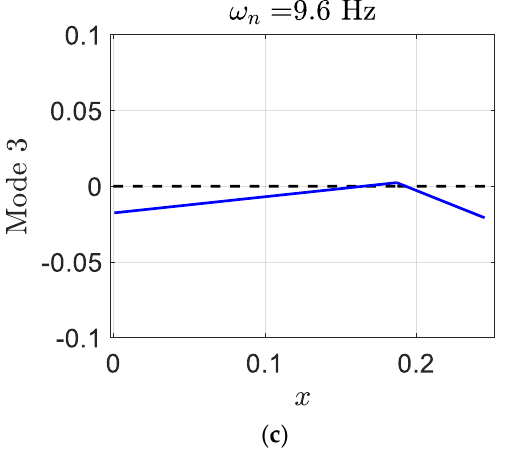
Figure 20. Mode shapes of the smart blade in unsteady plunge, pitch, and control at 𝑈 = 104.4198 m s⁄ : ( a ) 𝜔 𝑛 = 1.9 Hz ; ( b ) 𝜔 𝑛 = 6.9 Hz ; ( c ) 𝜔 𝑛 = 9.6 Hz .